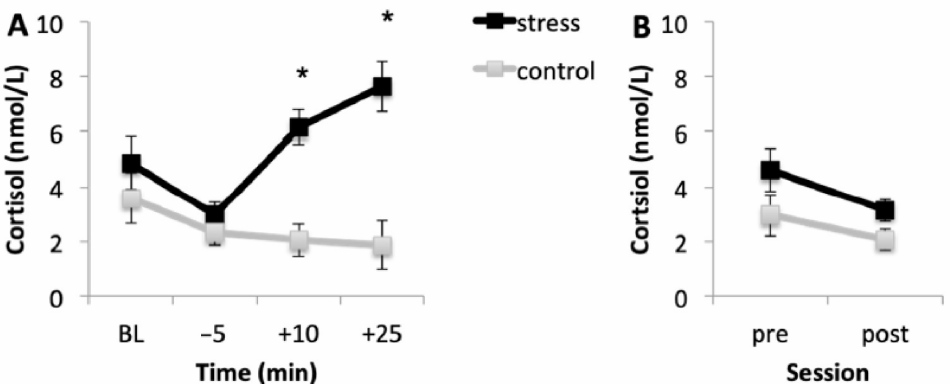
Figure 2. Salivary cortisol levels in the stress and control conditions for the acquisition session ( A ) and for the memory testing session ( B ). Error bars represent standard error of mean (S.E.M.). BL = baseline levels ( − 80 min) (* p <